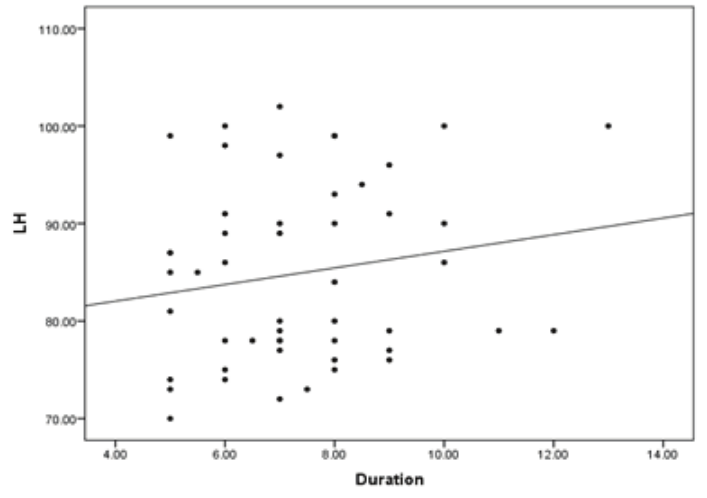
Figure 7 : Correlation of duration with LH in case group ( R = 0.172, P =